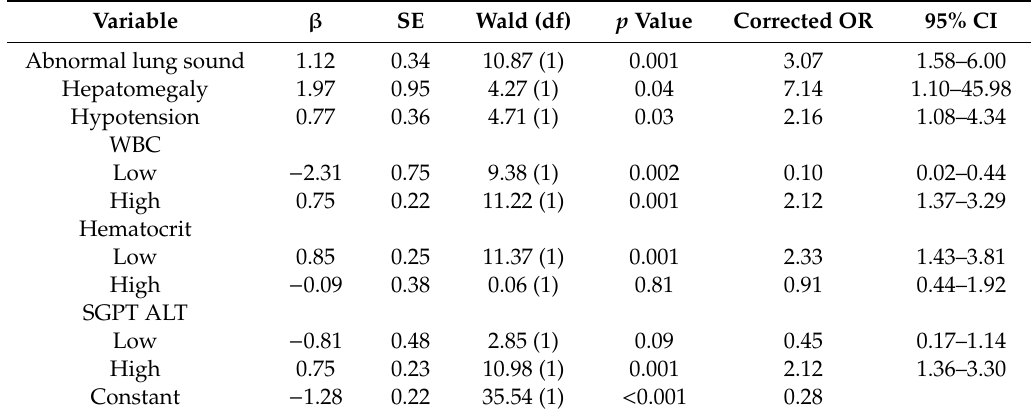
Table 5. Association between risk factors and severe